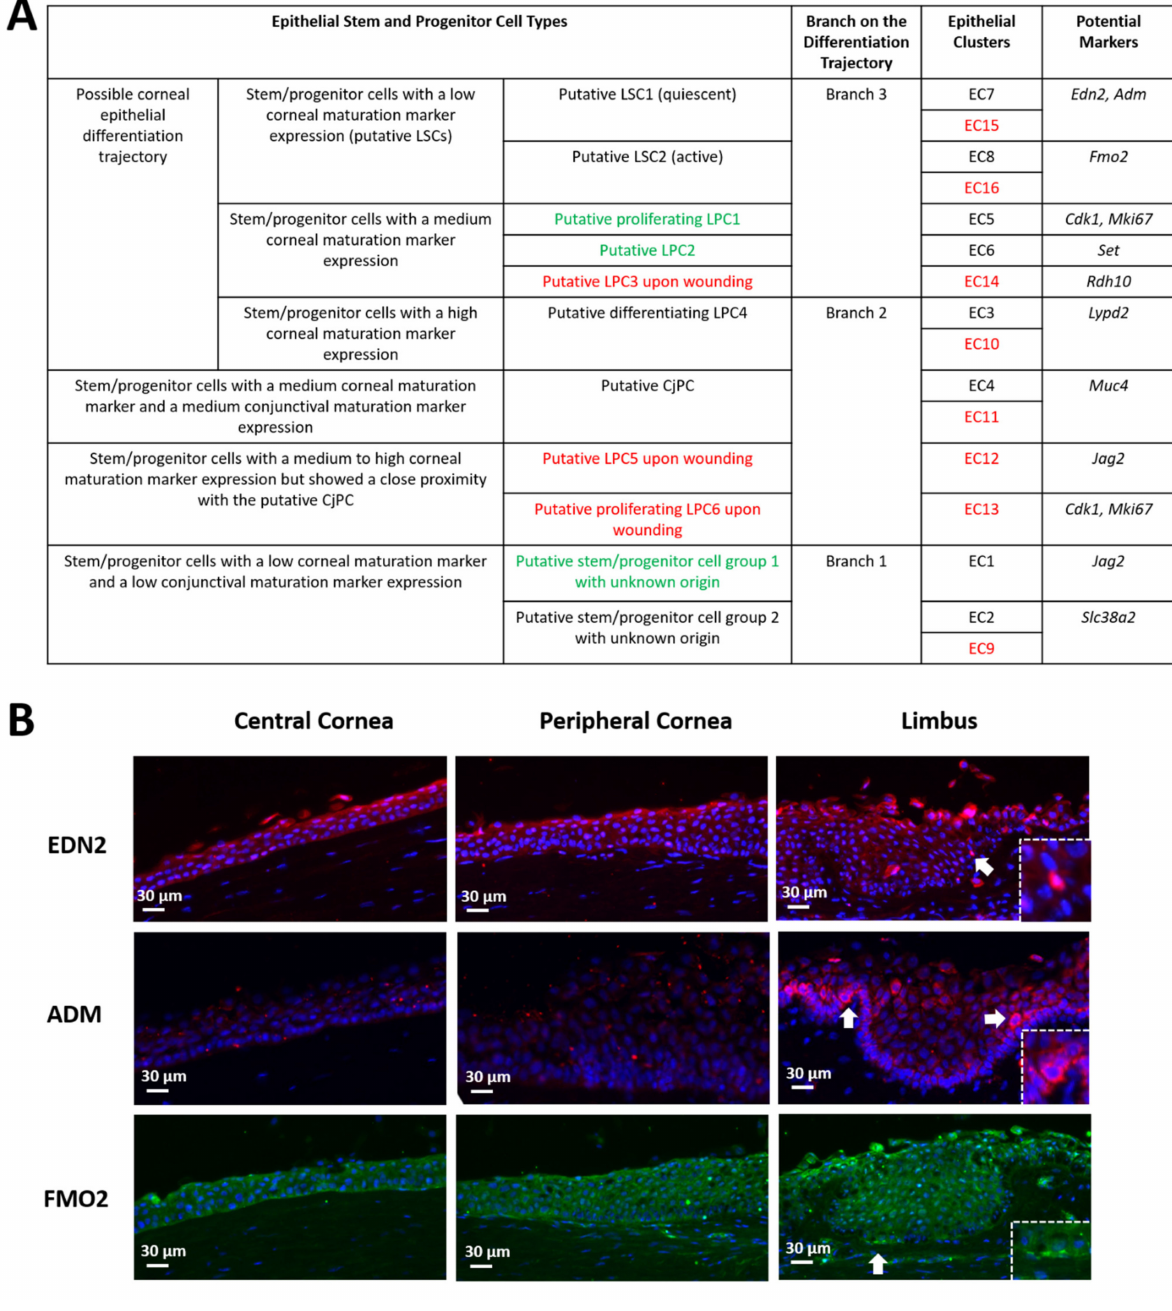
Figure 6. Putative LSC (limbal stem cell) and LPC (limbal progenitor cell) types revealed by single- cell RNA sequencing with characteristic markers. ( A ) The table showing different types of limbal epithelial stem and progenitor cells with characteristic markers. In the 3rd column, black font indicates cell types which were present under normal homeostasis and upon wounding; green font indicates cell types which were present under normal hemostasis but disappeared upon wounding; red font indicates cells types which were absent under normal homeostasis but appeared upon wounding. In the 5th column of “Epithelial Clusters”, black font indicates clusters under normal homeostasis, and red font indicates clusters upon wounding. ( B ) The two types of putative LSCs located as discrete cells at or near the basal limbal epithelium revealed by immunohistochemistry in human corneas using their characteristic markers. Arrows indicate the location of the cells with strong expression of the markers, which are shown as enlarged pictures in the squares at the bottom right